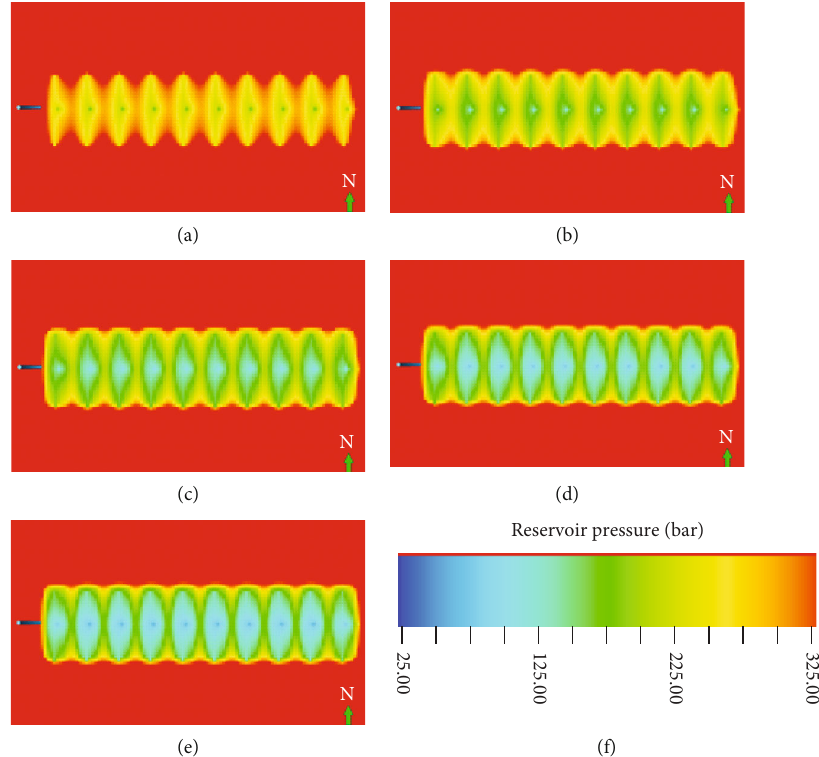
Figure 6: End-production pressure distribution under di ff erent permeability conditions in SRV zones: (a) SRV permeability is 0.02mD, (b) SRV permeability is 0.04 mD, (c) SRV permeability is 0.06mD, (d) SRV permeability is 0.08mD, (e) SRV permeability is 0.1mD, and (f) the legend of reservoir